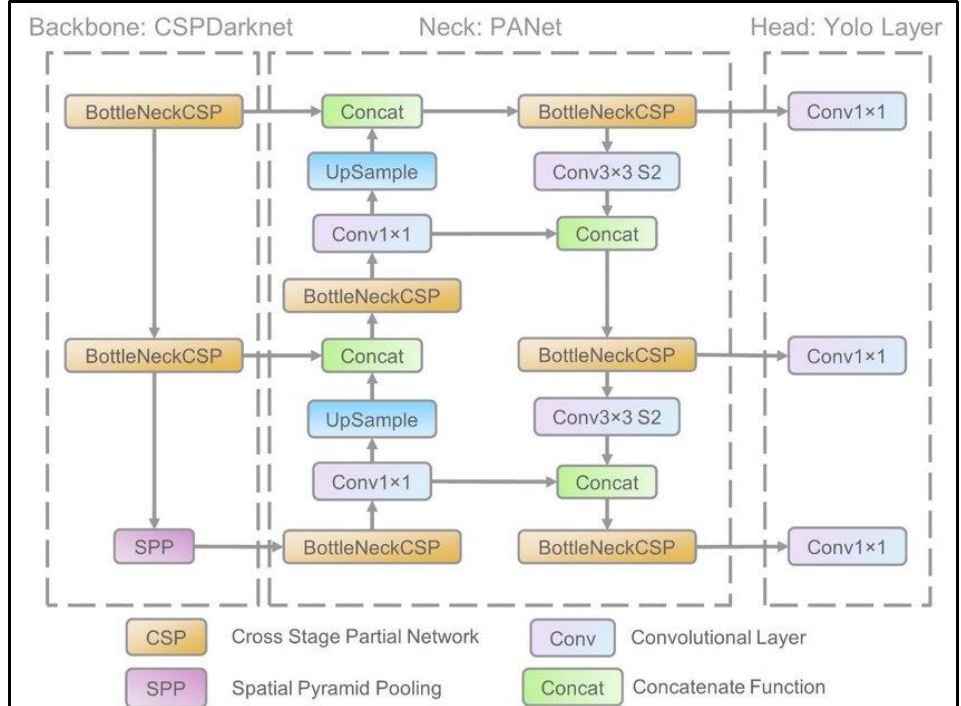
Figure 4. YOLOv5 Network Architecture.